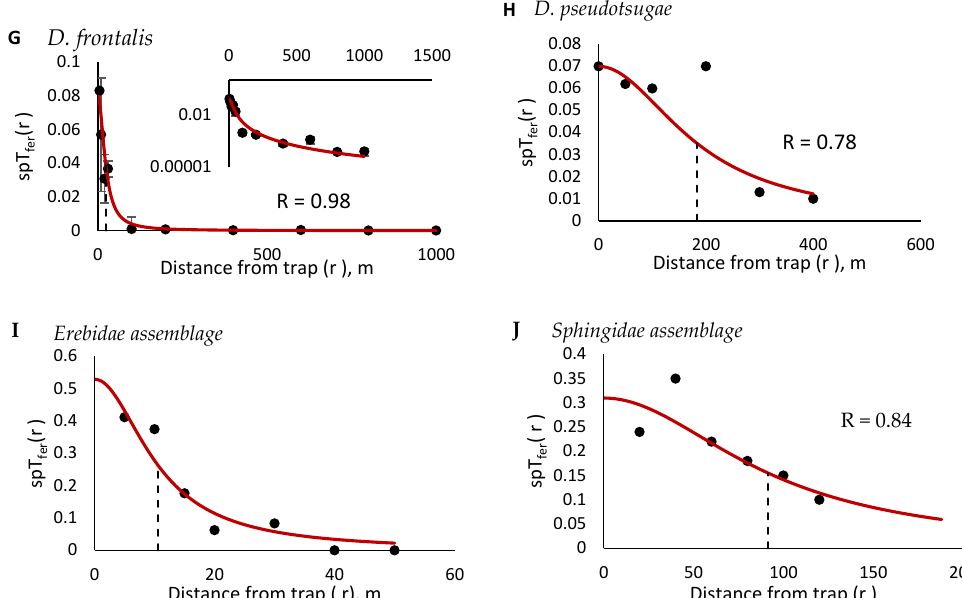
Figure 2. Proportion of insects caught in pheromone-baited traps placed at various distances from the release point (±SEM, where available). Black dots represent the experimental data, red lines represent the log – log model with spT fer (0) obtained using untransformed data. Black dashed lines mark D 50 estimated from the data as a distance, with spT fer ( r ) = 0.5 spT fer (0). L. dispar ( A ), C. pomonella ( B ), H. halys ( C ), N. sertifer ( D ), D. suzukii (E), D.virgifera ( F ), D. frontalis ( G ), D. pseudotsugae ( H ), Erebidae assemblage ( I ), Sphingidae assemblage ( J ). For L. dispar ( A ), C. pomonella ( B ), H. halys ( C ), and D. frontalis ( G ), the insets show the fit in logarithmic scale on the y-axis, ln(spT fer ( r )), to better illustrate the behavior at large distances from the trap, where trap catches are very low.